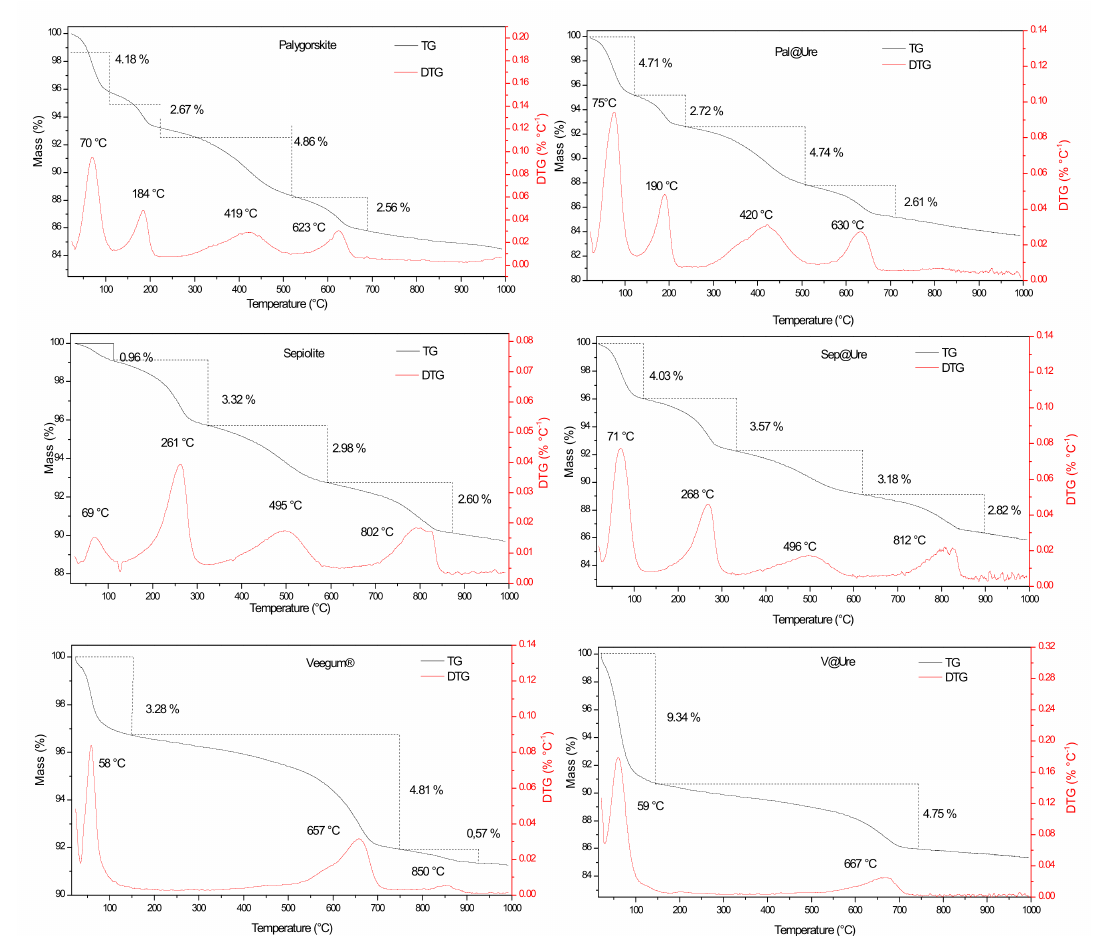
Figure 3. TG and DTG curves of the clay minerals before and after urea